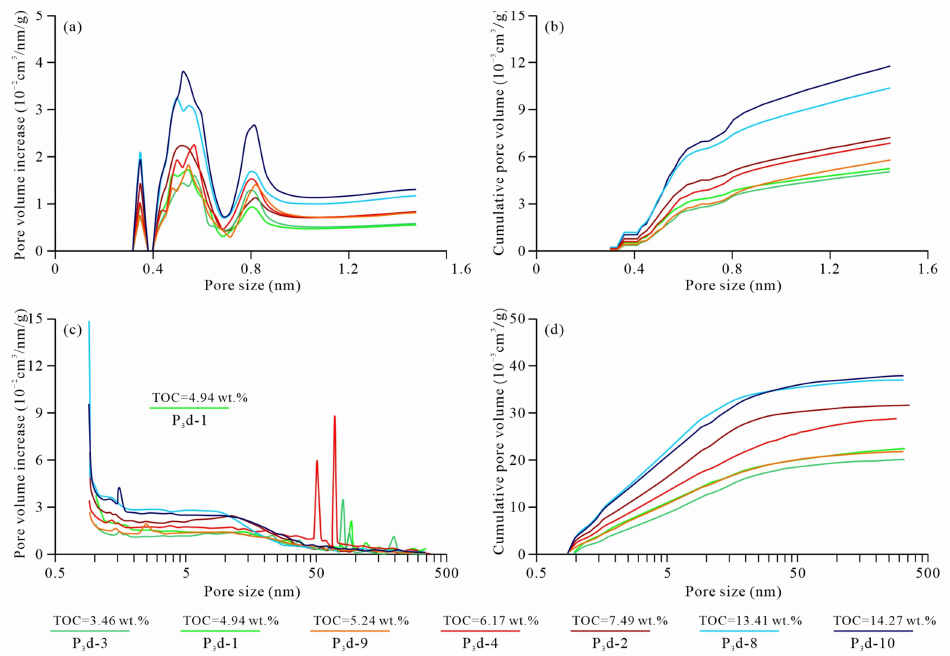
Figure 11. Pore size distributions were obtained by ( a , b ) CO 2 and ( c , d ) N 2 adsorption tests of the Dalong Formation shale samples from well ED-2. Correlations are shown between pore size and ( a , c ) pore volume increase and ( b , d ) Cumulative pore volume. Different curves (colors) represent different